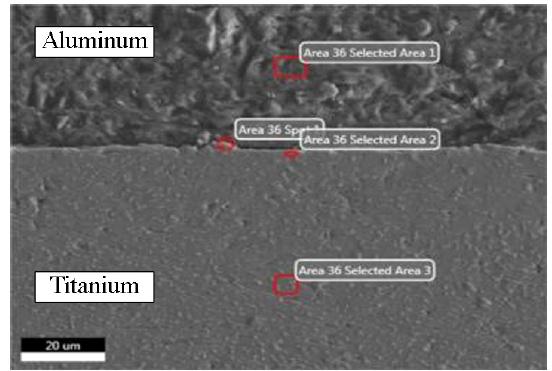
Figure 10. EDS analysis areas on the sample welded at 520 °C for 60 min.